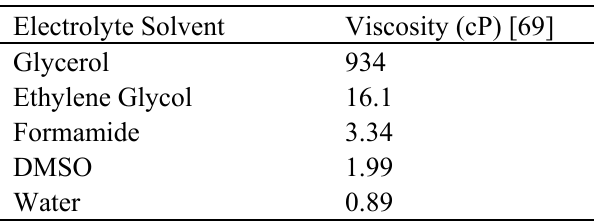
Table 4. Solvent